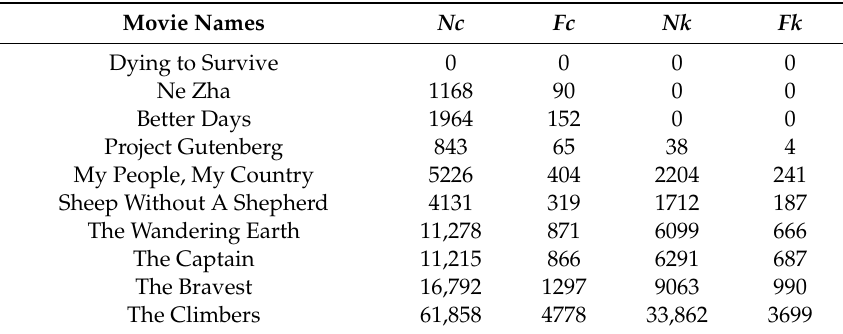
Table 4. The analysis of malicious user